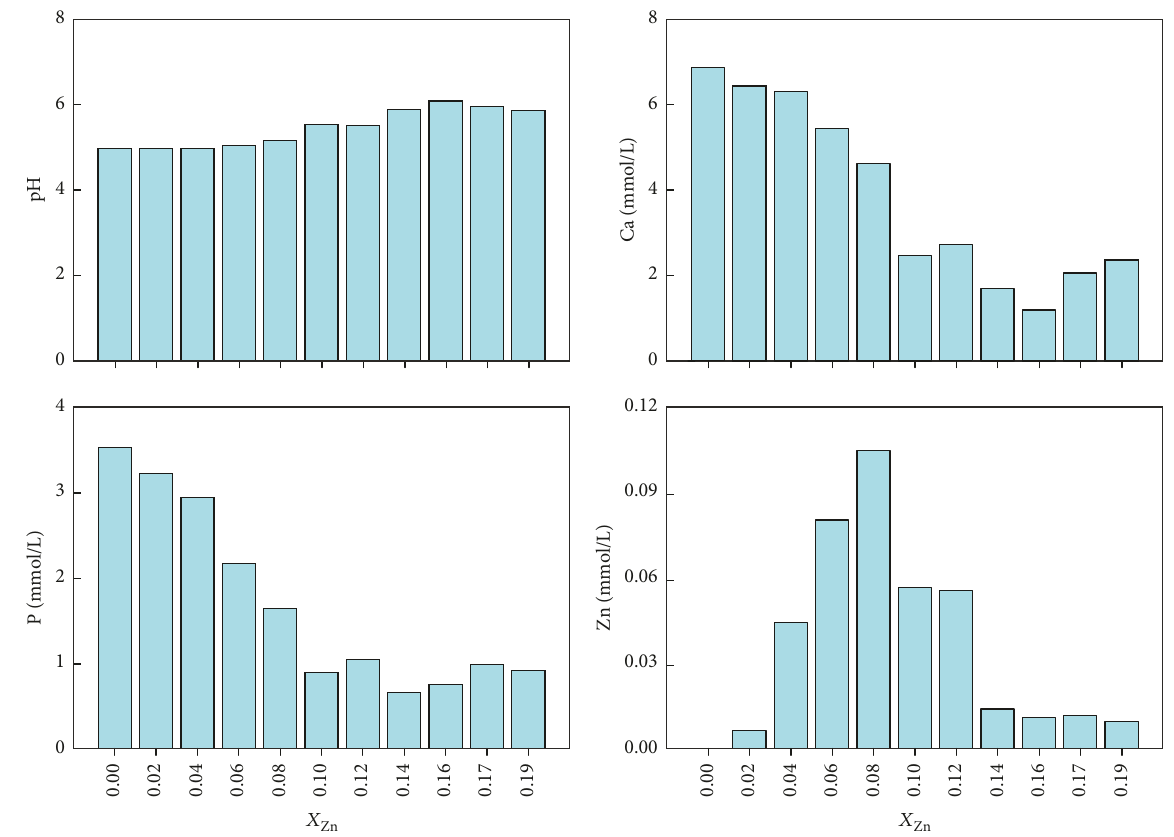
Figure 5: The solution pH and elemental concentrations after the dissolution of the Zn-substituted hydroxylapatites [(Zn at 25 ∘ C with an initial pH of 2.00 for 360 d.